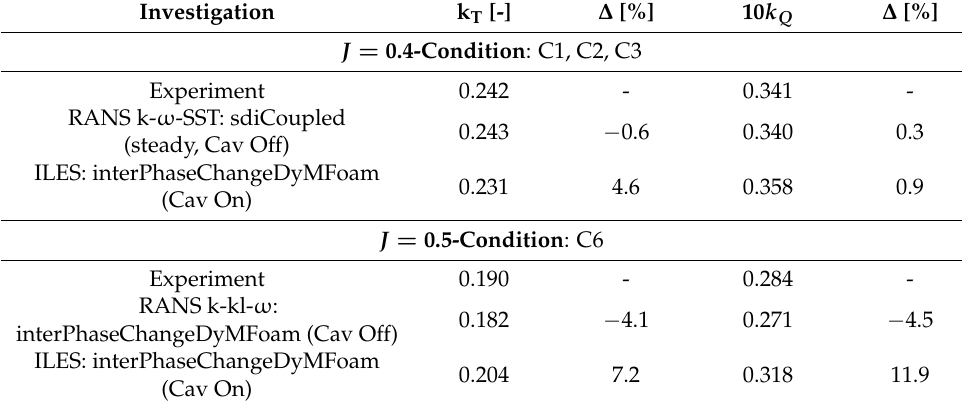
Table 7. Integral values at J = 0.4 and J = 0.5, Newcastle propeller test